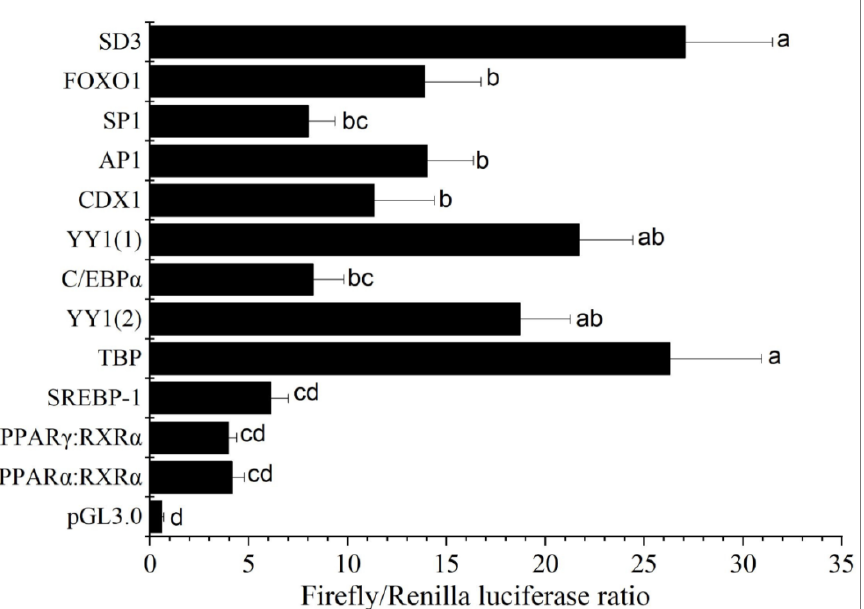
Figure 7. The effects of site-directed mutation of transcription factor binding sites on the promoter activity of common carp acsl6 gene: Mutations of promoter deletion on SD3 (wild type, −758 to ATG) were generated according to in silico predications as shown in Figure 4, and the effects of mutation on promoter activity were compared with SD3. Promoter activity of constructs is represented on the right with the values representing normalized activity (Firefly luciferase–Renilla luciferase). Bars not sharing a common letter indicated significant differences ( p < 0.05) among deletions determined by one-way ANOVA followed by Tukey’s multiple comparison test.